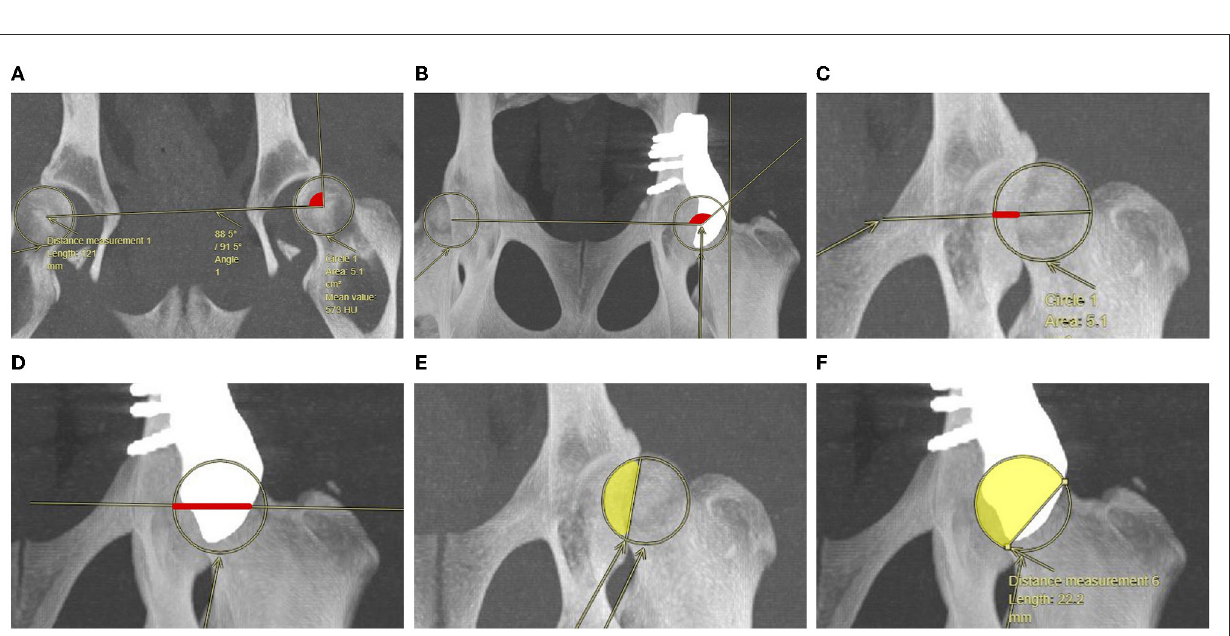
FIGURE1 Representation of Norberg angle (A, B) , percentage of linear femoral head overlap (red line) (C, D) and percentage of femoral head coverage (yellow area) (E, F) , as measured in coronal CT images compared between before (A, C, E) and after implantation of a titanium shelf implant for acetabular rim extension (B, D, F)